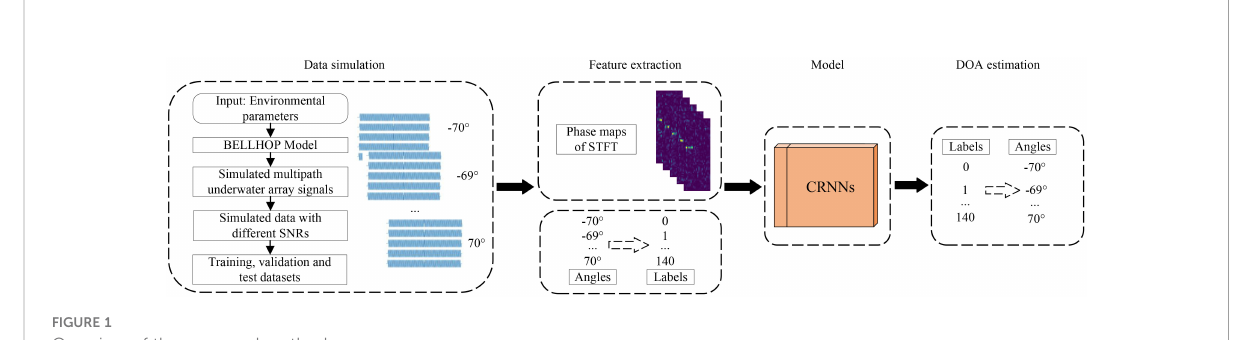
FIGURE 1 Overview of the proposed